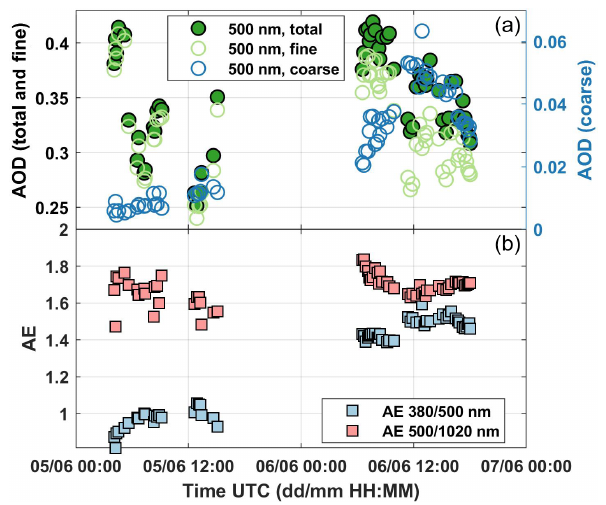
Figure 3. AERONET sun-photometer observations (in Kuopio sta- tion, on 5 and 6 June 2019, http://aeronet.gsfc.nasa.gov, last access: 3 May 2021) of (a) 500nm aerosol optical depth (level 2.0 data) and (b) Ångström exponents (AEs) computed from the optical depths measured at 380, 500, and 1020nm. The fine-mode-related (for par- ticle with diameters < 1µm) and coarse-mode-related aerosol opti- cal depth (diameters > 1µm) are also shown ( a , level 2.0 aerosol spectral deconvolution algorithm (SDA)